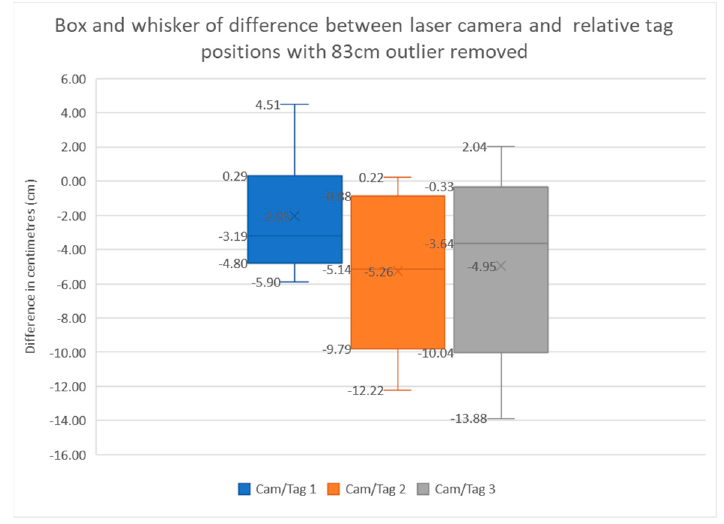
Figure 14. Box − and − whisker plot described by its title.